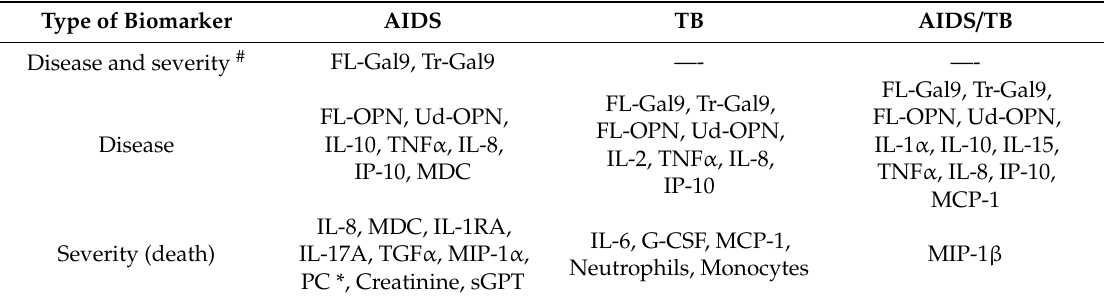
Table 3. Candidates of disease specific and severity (death)-related biomarkers. Type of Biomarker AIDS Disease and severity #